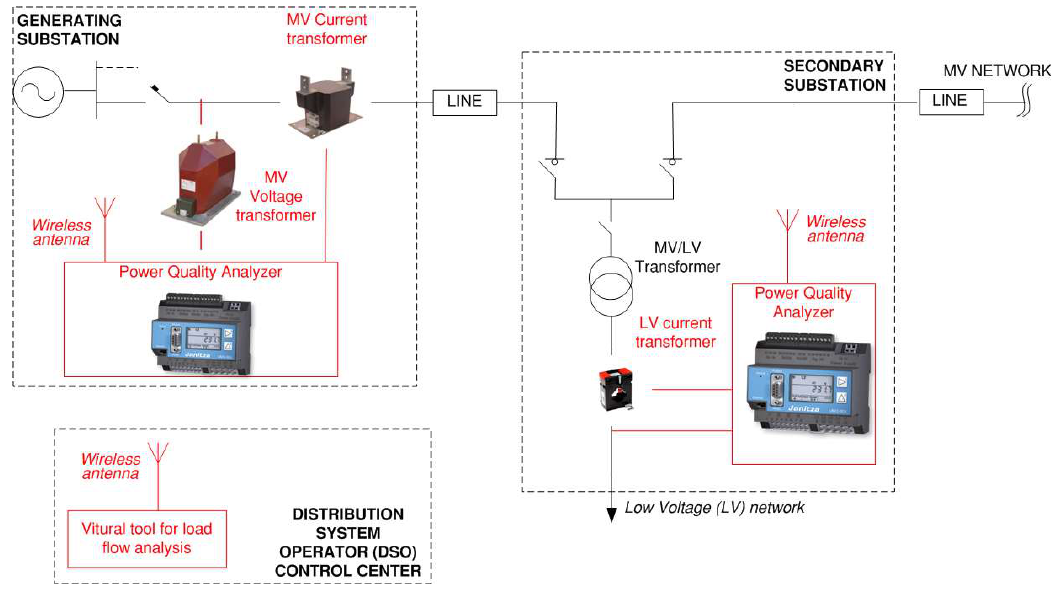
Figure 1. Proposed architecture for the medium voltage (MV) distribution network monitoring.